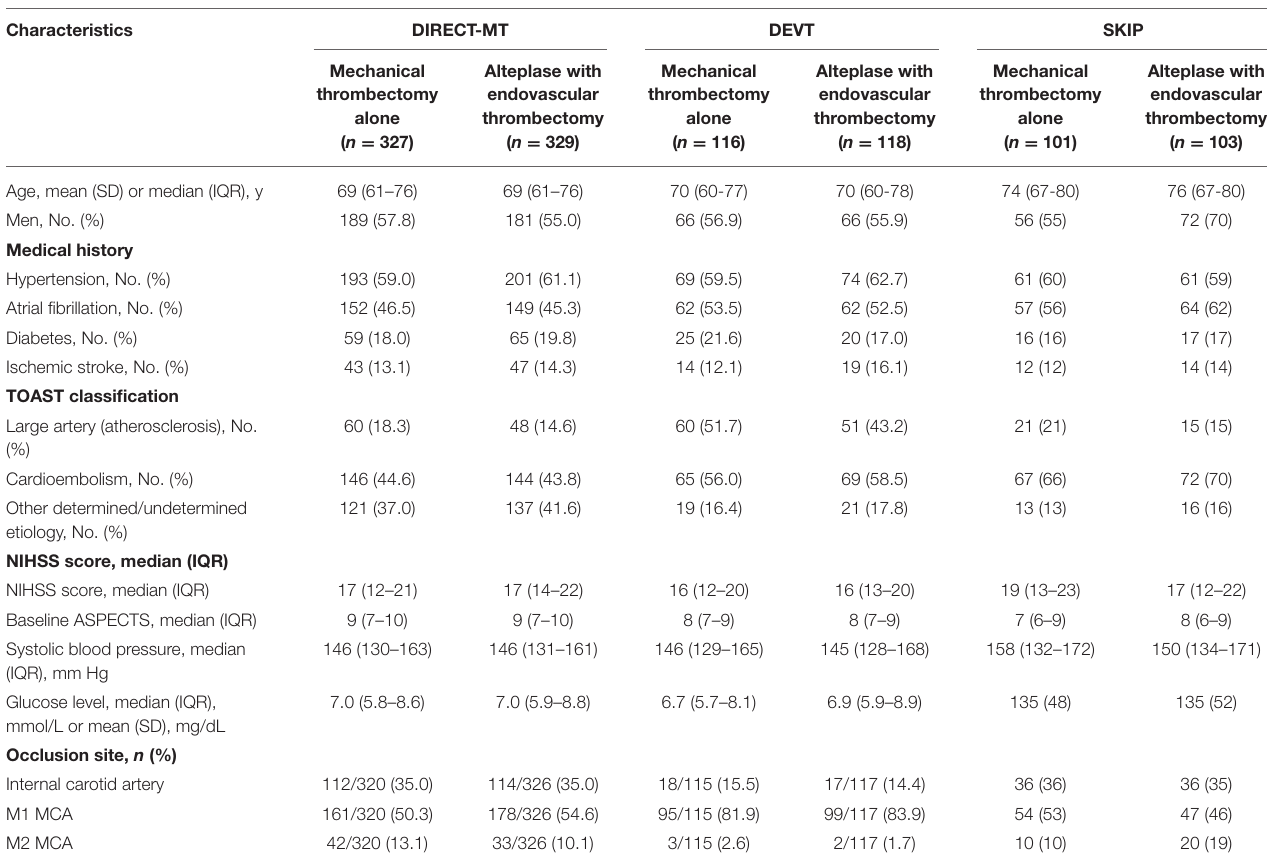
TABLE 2 | Baseline patient characteristics among included randomized clinical trials.